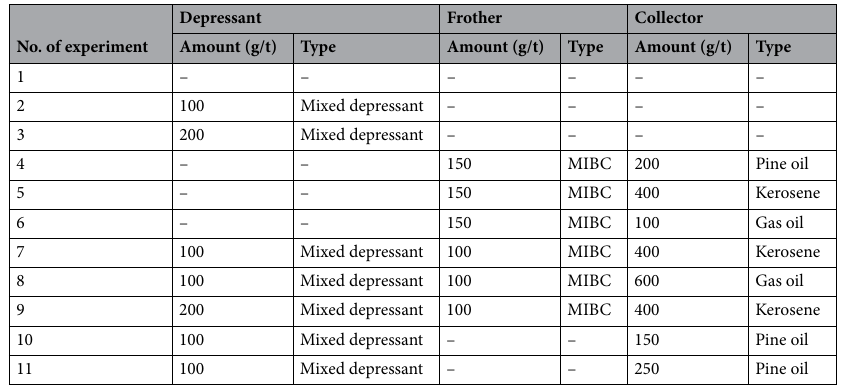
Table 5. Conditions and specifications of gilsonite flotation experiments based on the type and amount of reagents.